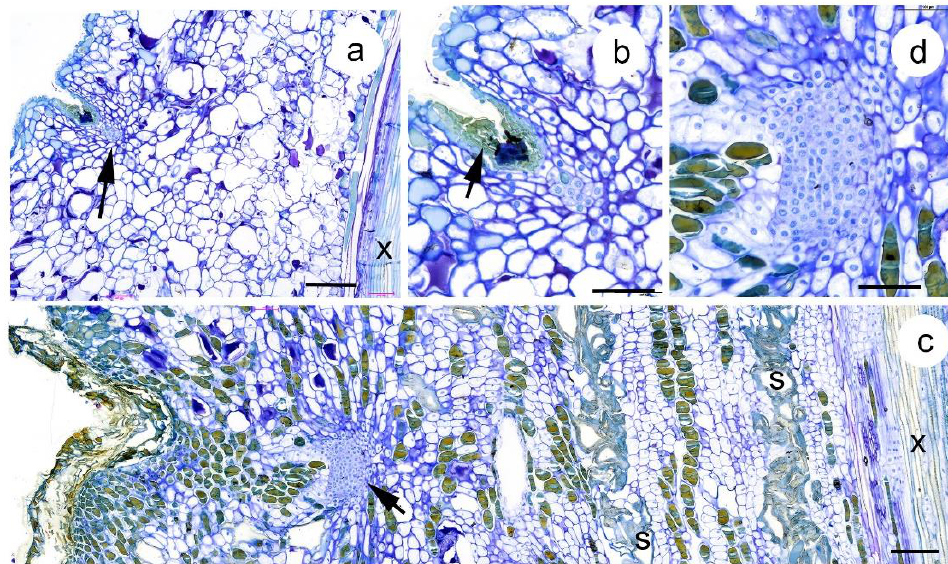
Figure 4. Radial longitudinal sections of the leaf axils of Wollemia nobilis . ( a ) Leaf axil from a plagiotropic first order branch of juvenile morphology. Note the location of the axillary meristem (arrowed) and the xylem of the central vascular cylinder (x). Scale 200 µ m. ( b ) Detail of a) showing the small axillary meristem (note the large nuclei and dense cytoplasm) and the bark patch (arrow), the activity of which resulted in the axillary meristem being located below stem level. Scale 100 µ m. ( c ) Leaf axil from the orthotropic leader of a mature tree. Note the xylem (x) of the central vascular cylinder, the sclereid (s) bands in the cortex and the relatively deeply buried axillary meristem (arrowed). Scale 200 µ m. ( d ) detail of ( c ) showing the axillary meristem has a distinct outer layer, while it gradually merges into the cortex to the rear. Note the absence of leaf primordia or vascular connections. Scale 100 µ